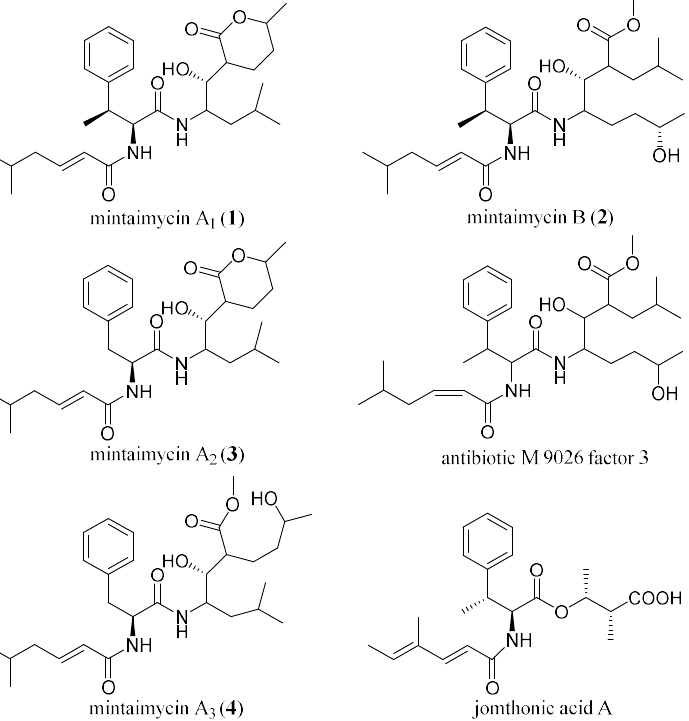
Figure 3. Structures of mintaimycins ( 1 – 4 ), antibiotic M 9026 factor 3 and jomthonic acid A.